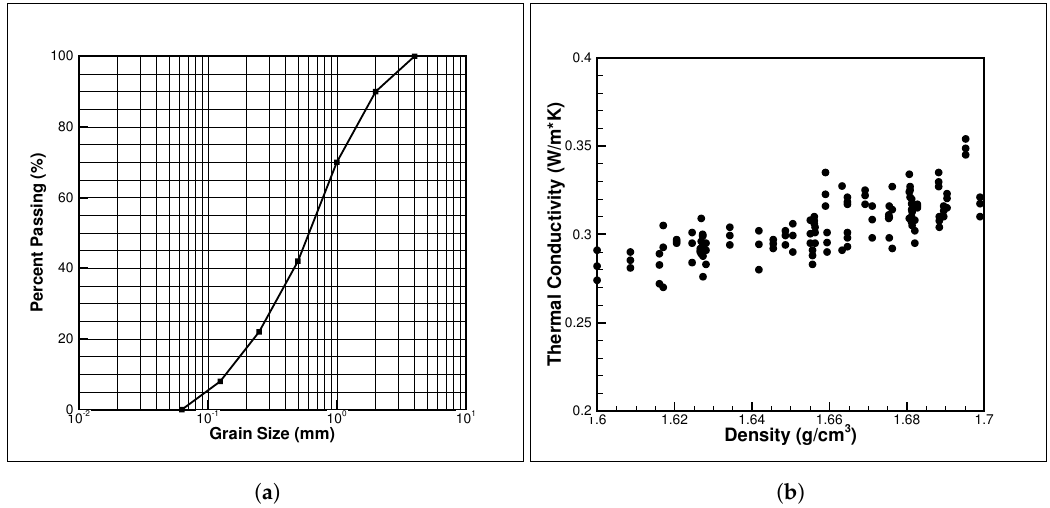
Figure 4. Physical properties of sand ( a ) particle size distribution of sand; ( b ) thermal conductivity measurements at different dry densities of